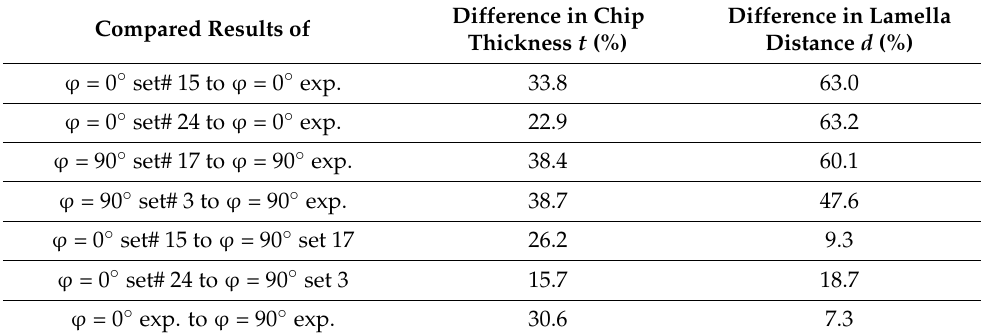
Table 7. Chip Shape Criteria T and D Depending on Model and Experiment-Based Results. Compared Results of